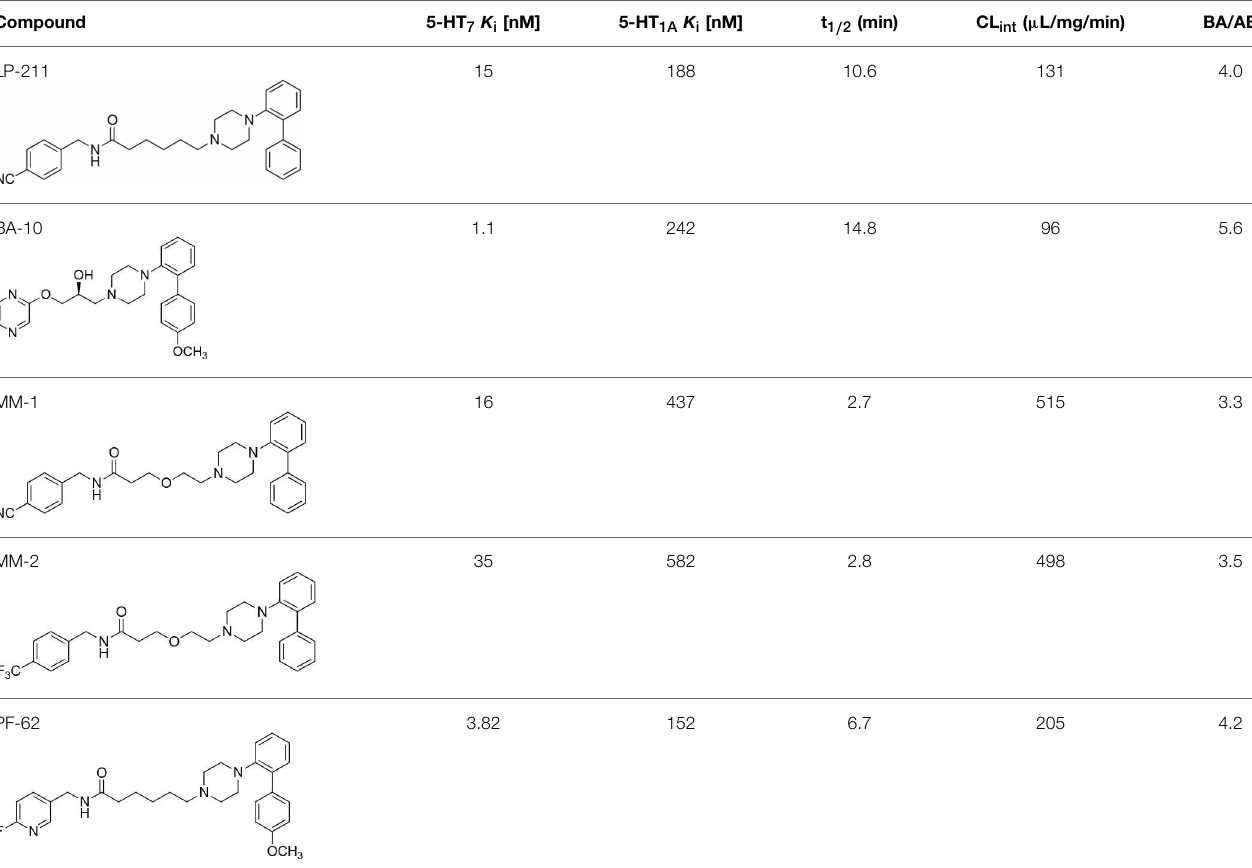
TABLE 1 | Binding Affinity Data and Pharmacokinetic Parameters of Test Compounds.